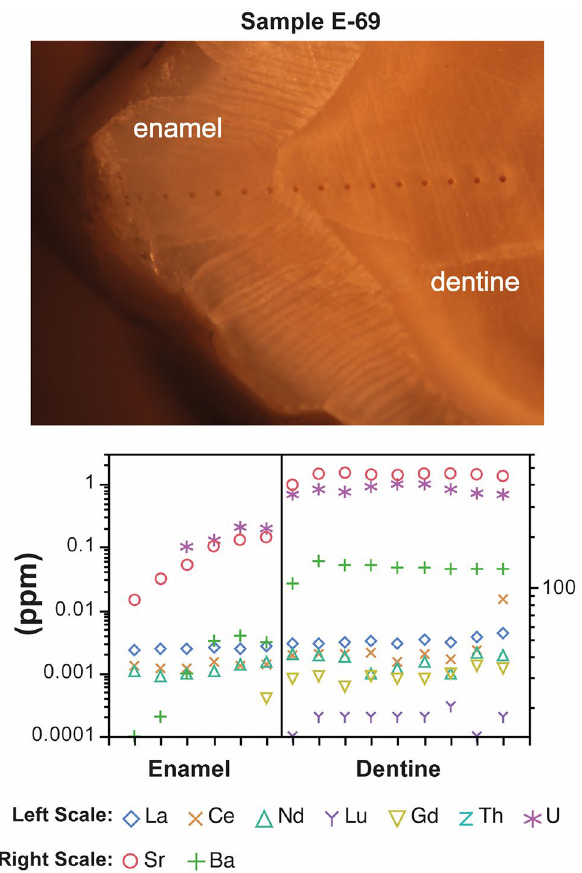
Figure 2. Top: Photomicrograph of the lower left second molar of Individual E69 from the Valdescusa site. The spots generated during the analysis by LA-ICP-MS can be observed (original fotograph by LA Ortega). Bottom: content (in ppm) of elements sensitive to